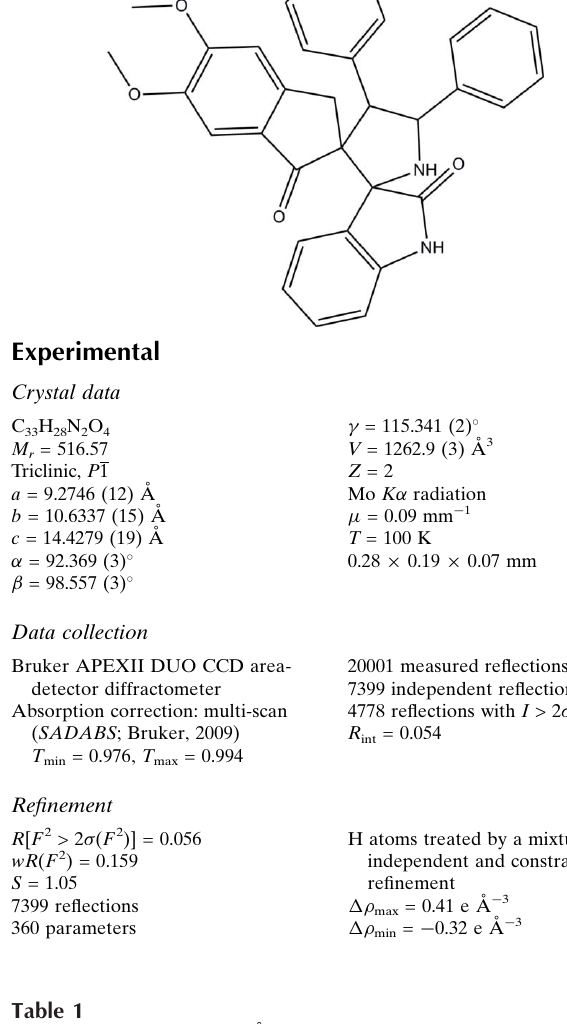
Hydrogen-bond geometry (A˚ , (cid:2)